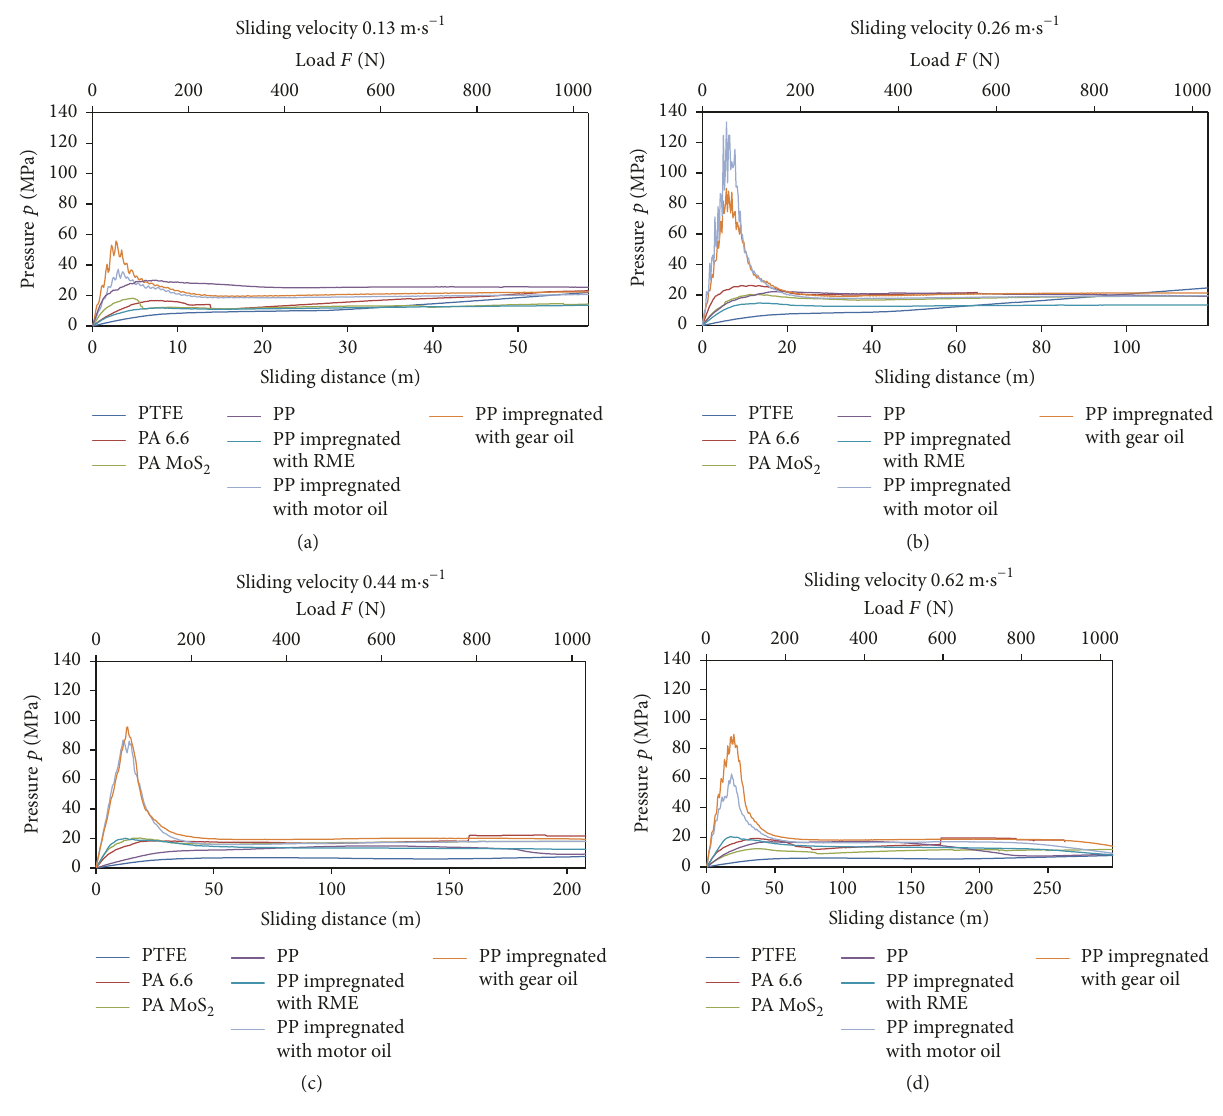
Figure 7: Relationships between sliding distance, load, and pressure of the samples under various sliding velocities: (a) 0.13, (b) 0.26, (c) 0.44, and (d) 0.62 m ⋅ s −1